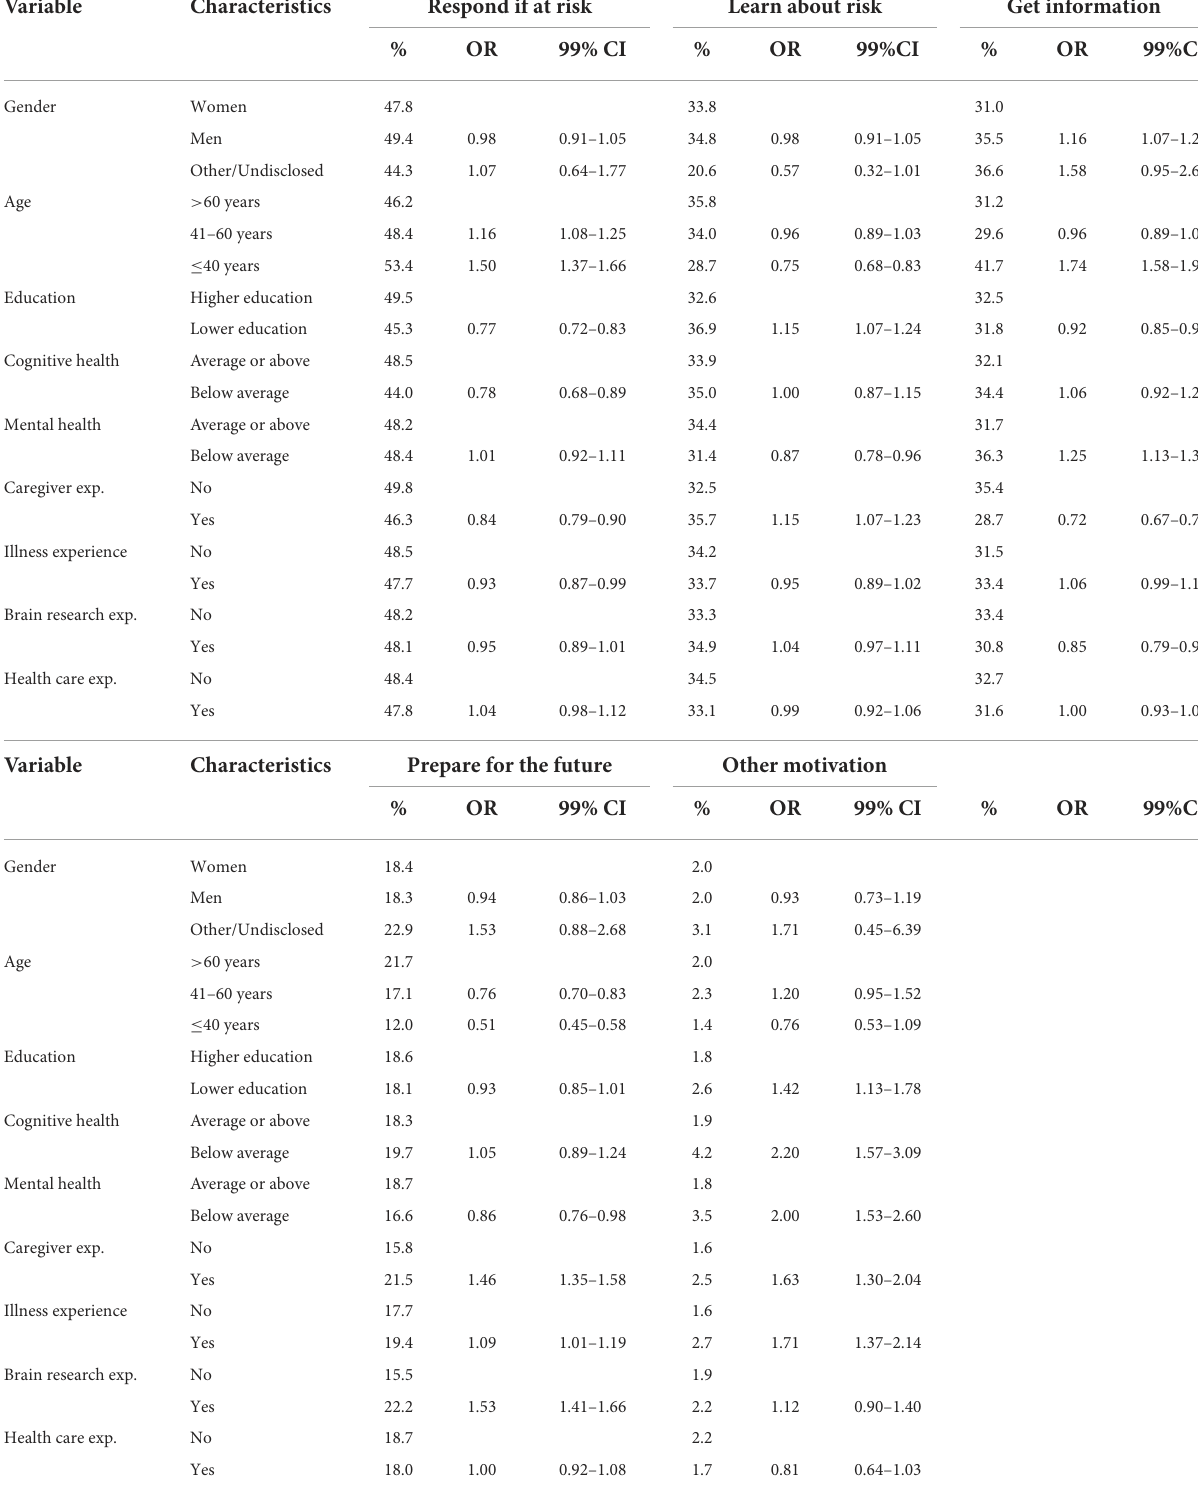
TABLE 2 Reasons for wanting to take a brain health